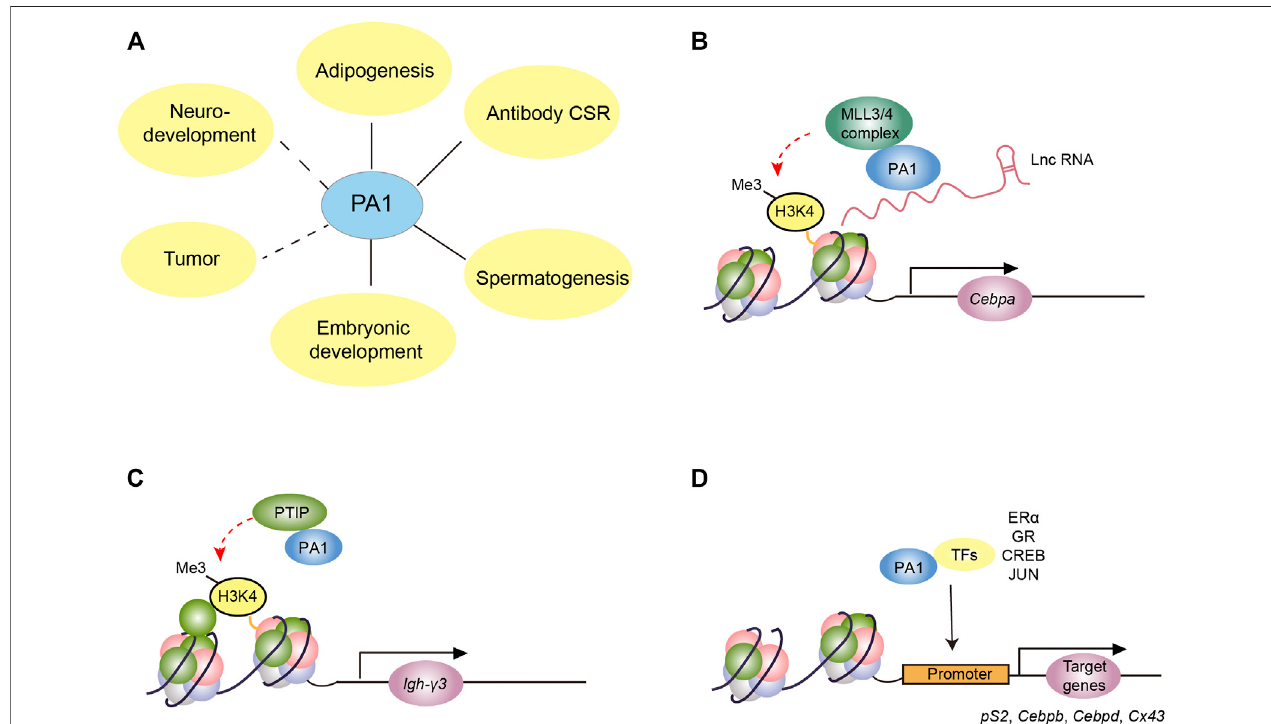
FIGURE 2| The molecular function ofPA1 in different biological processes. (A) The involvement ofPA1 in different biological processes. The solid line indicates the veri fi edrelationshipbetweenPA1andthebiologicalprocesswhilethedashedlinedenotesthepotentialfunctionsofPA1inthesebiologicalprocesses. (B) PA1functions as a link between lncRNA and MLL3/4 complex and participates in MLL3/4-dependent H3K4me in promoting the expression of CEBPA in adipogenesis. (C) PA1, together with PTIP, is involved in the transcription initiation of noncoding germline transcriptssuch as Igh- γ 3 through MLL3/4-independent H3K4me in B cell CSR. (D) PA1 binds with some transcription factors including steroid receptors, SMADs, CREB, and JUN to regulate the downstream gene expression such as Ps2, Cebpd, and Cx43